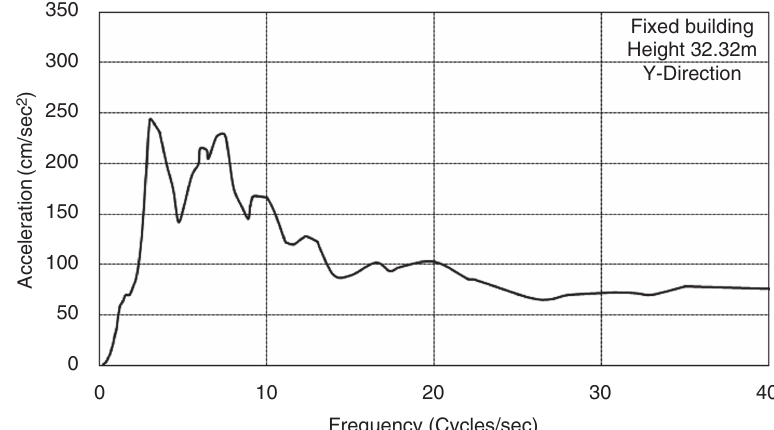
Fig. 7. Spectral Acceleration in Y-direction ( fi xed building)